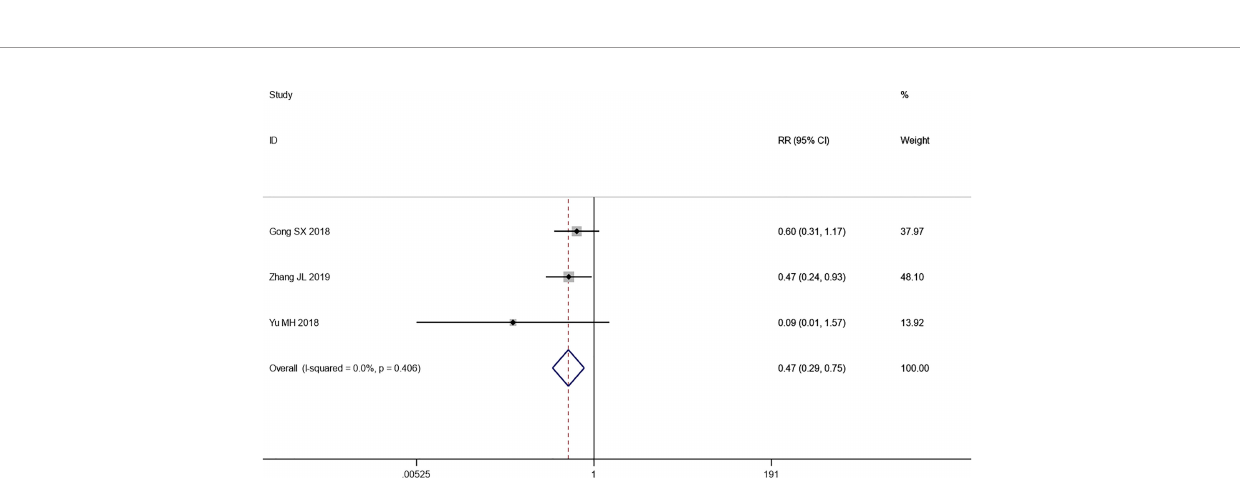
FIGURE 8 | Forest plot of the meta-analysis of AEs between the intervention group and the control